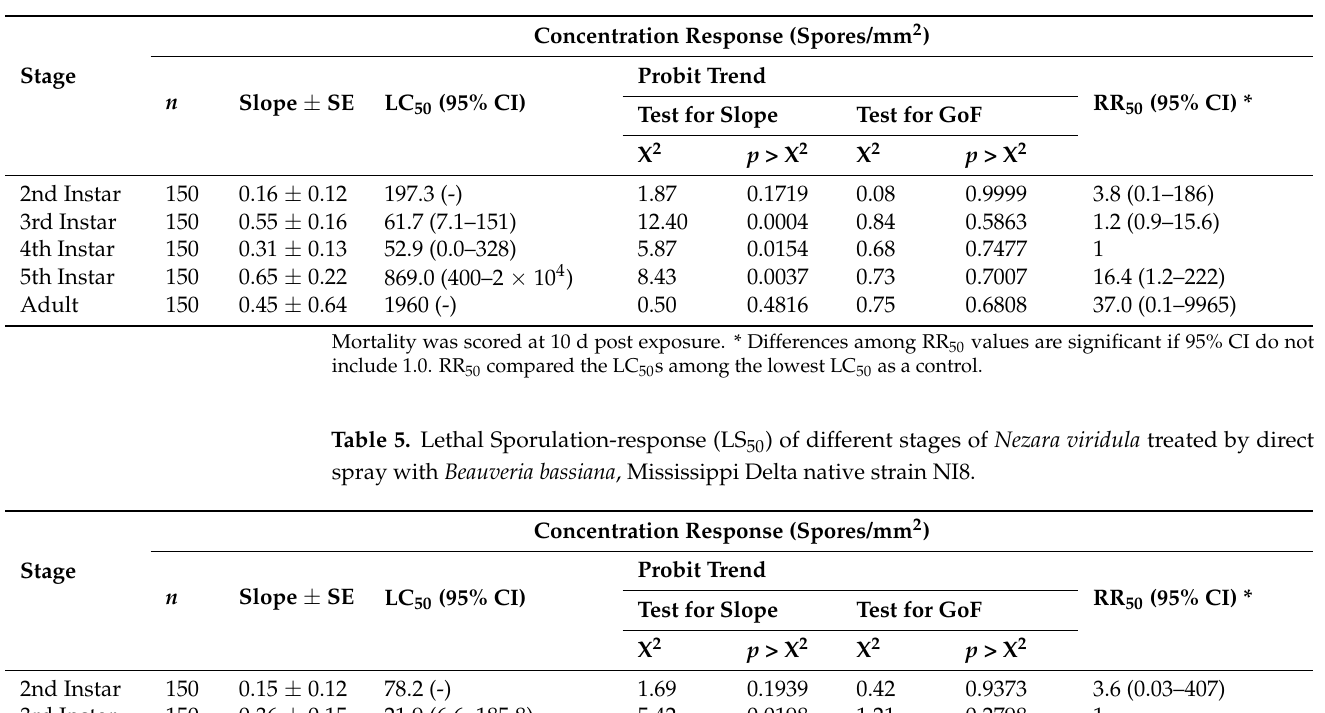
Table 4. Lethal Sporulation-response (LS 50 ) of different stages of Nezara viridula treated by contact with Beauveria bassiana , Mississippi Delta native strain NI8.